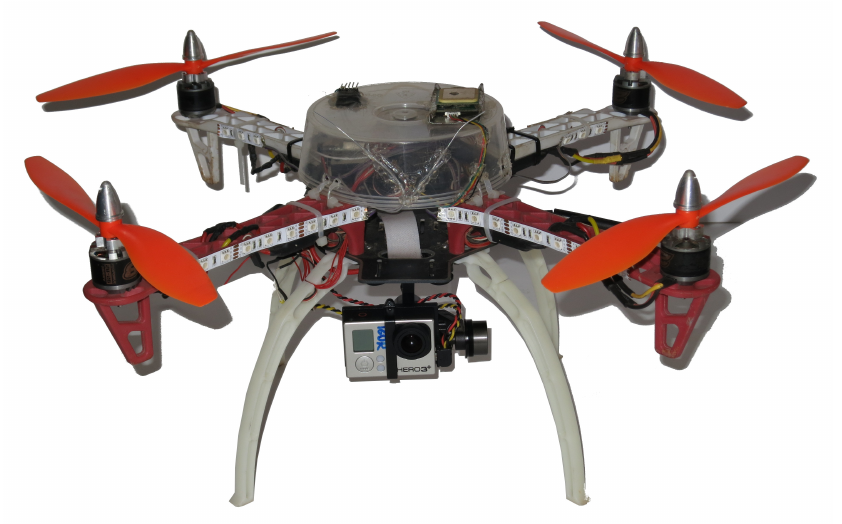
Figure 7. The UAV prototype we used on our